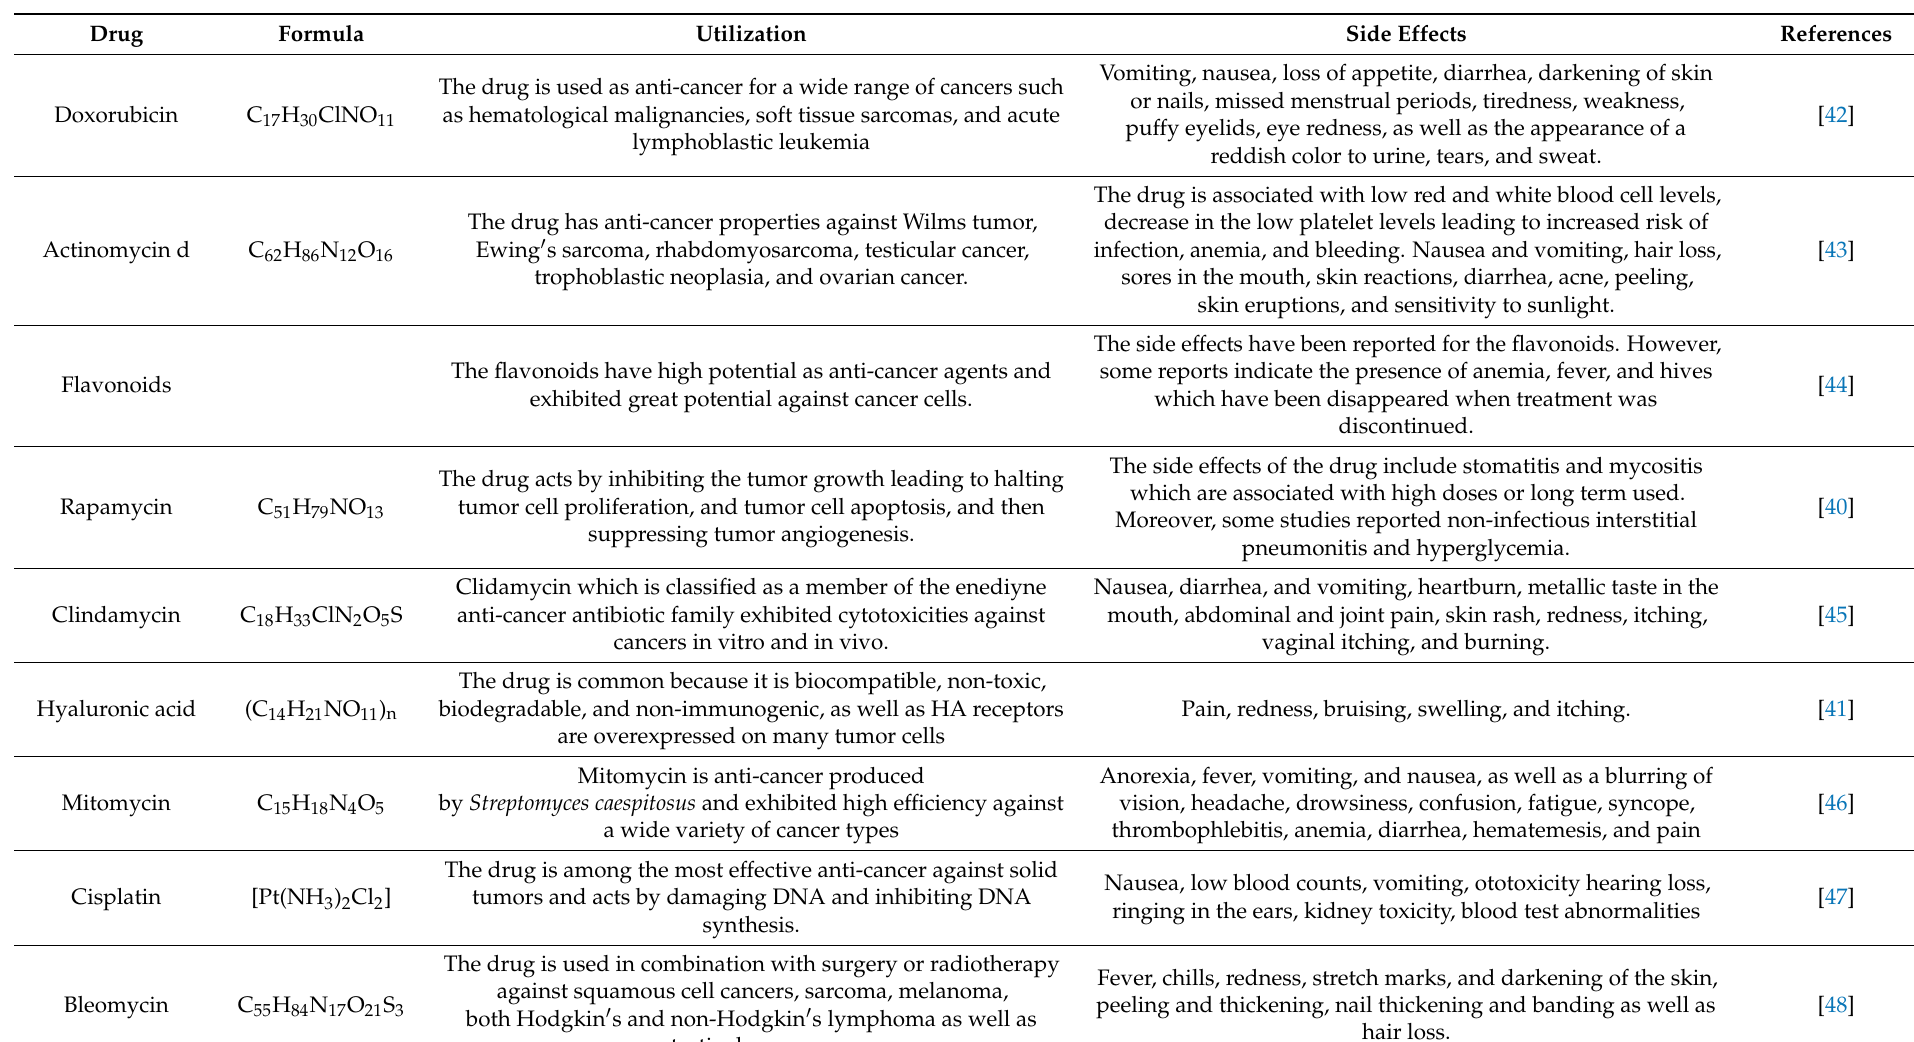
Table 4. Some common drugs used for cancer treatment and their side